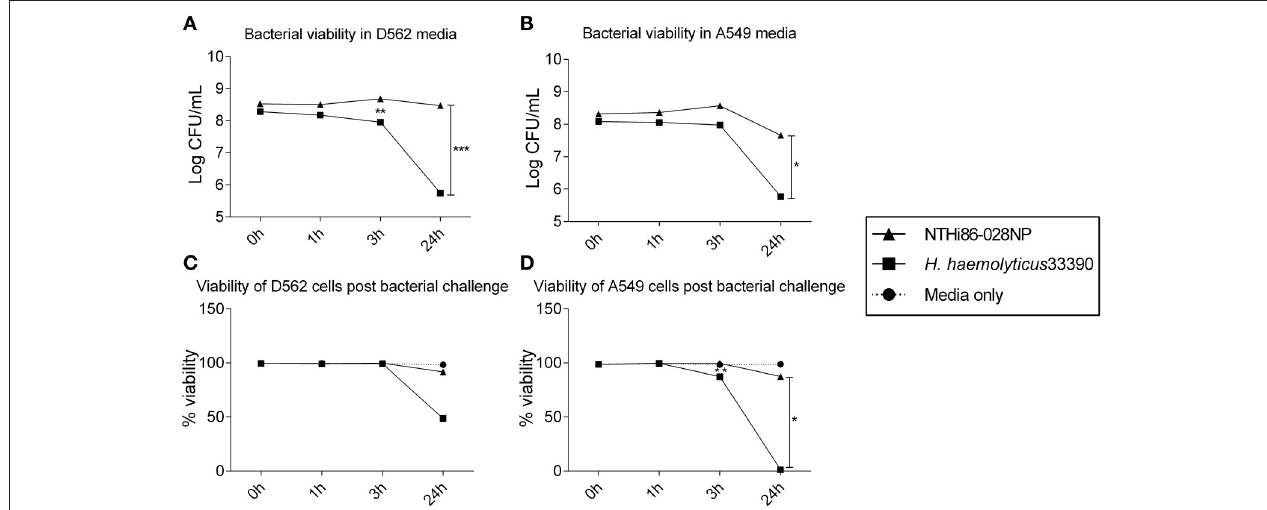
FIGURE 1 | Viability of respiratory epithelial cells co-cultured with H. haemolyticus and NTHi. Viability of NTHi86-028NP and H. haemolyticus 33390 in D562 (A) and A549 (B) cell culture media (no epithelial cells) over 24h as determined by viable count.Viability of D562 (C) and A549 (D) respiratory epithelial cells incubated with media only (circles), H. haemolyticus 33390 (squares), or NTHi86-028NP (triangles) over 24h as determined by trypan blue counts. Student’s t -tests were used to compare log transformed bacterial viability and Mann Whitney U -tests were used to compare post bacterial challenge epithelial cell viability, where * p < 0.05 , ** p < 0.01 , *** p < 0.001